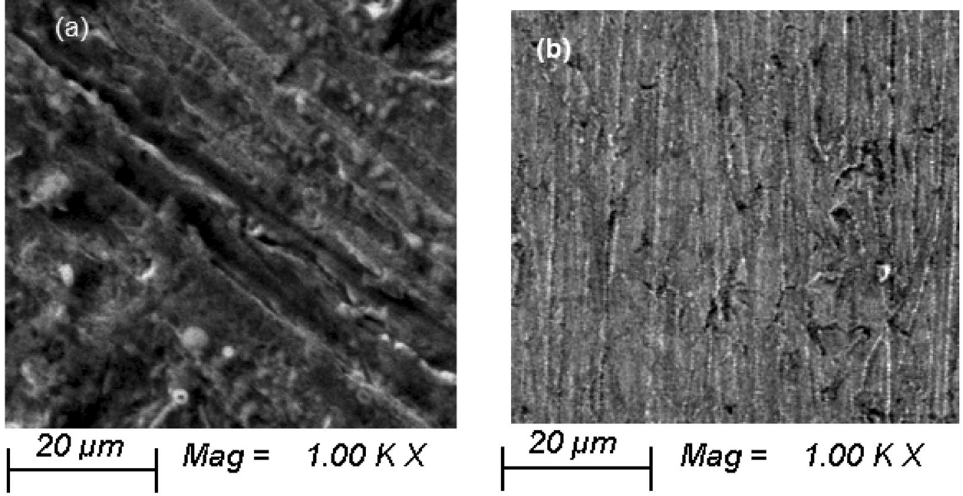
Figure 9. SEM images for X52-steel corrosion in pickling solution (1.0 M HCl) without ( a ) and with ( b ) 400 mg L −1 of BLE extract at 298 K.